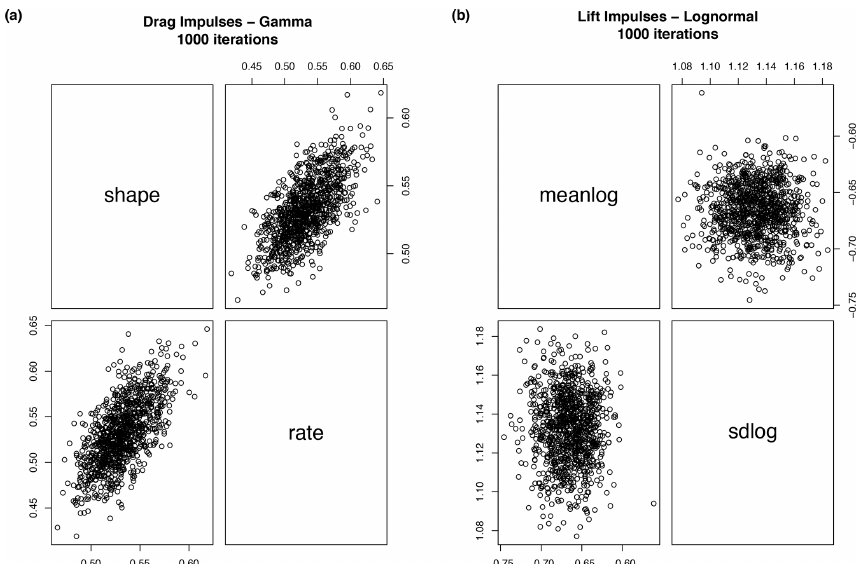
Figure F3. Bootstrap parameters for selected distributions. The graphs quantify the stability of the selected distributions for drag and lift impulses. For the gamma distribution (drag impulses) 1000 bootstrapped parameters were cross-compared, revealing a range of 0.1 for the shape parameter and 0.2 for the rate parameter (a) . For the lognormal distribution (lift impulses) 1000 bootstrapped parameters were cross-compared, revealing a range of 0.15 for the log-mean parameter and 0.14 for log standard deviation parameter (b) . The differences are marginal, indicating good stability of the selected distributions for the scaling of the